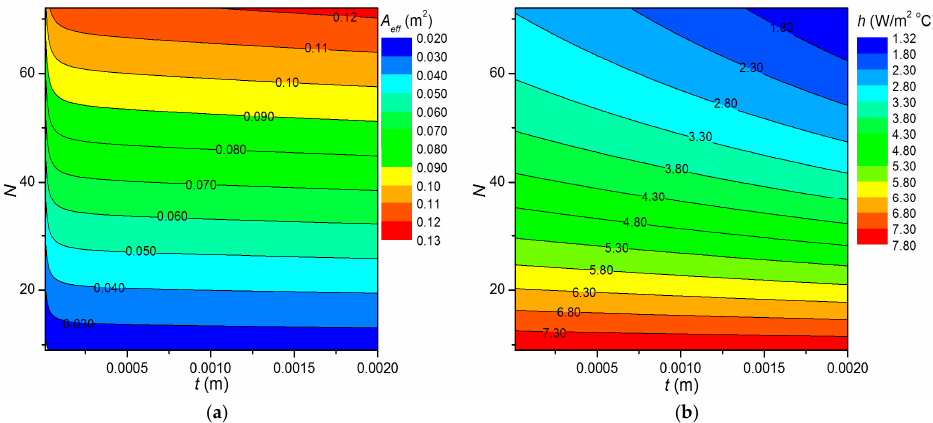
Figure 13. Contour maps of ( a ) effective surface area and ( b ) heat transfer coefficient. Table 4. Properties and constraints for contour maps.